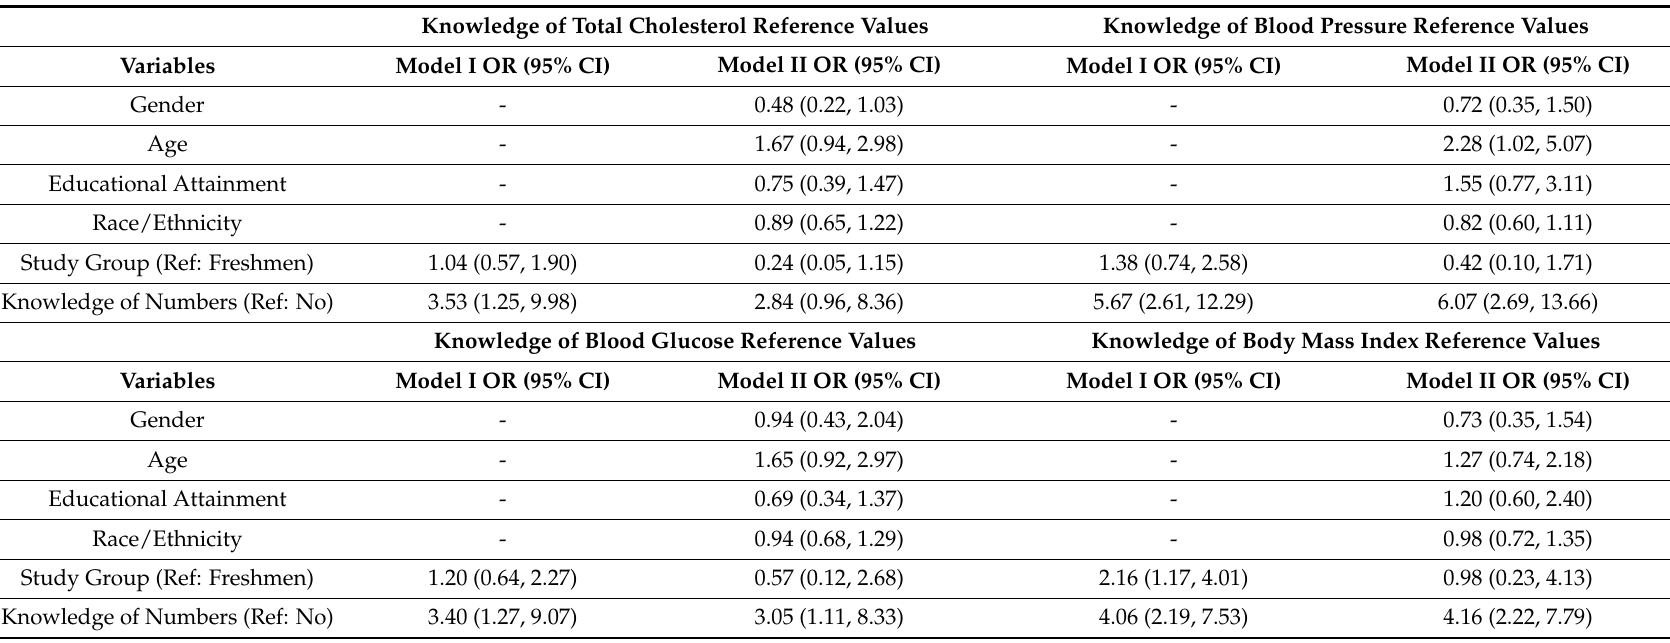
Table 3. Association between knowing one’s numbers and knowledge of reference values of healthy